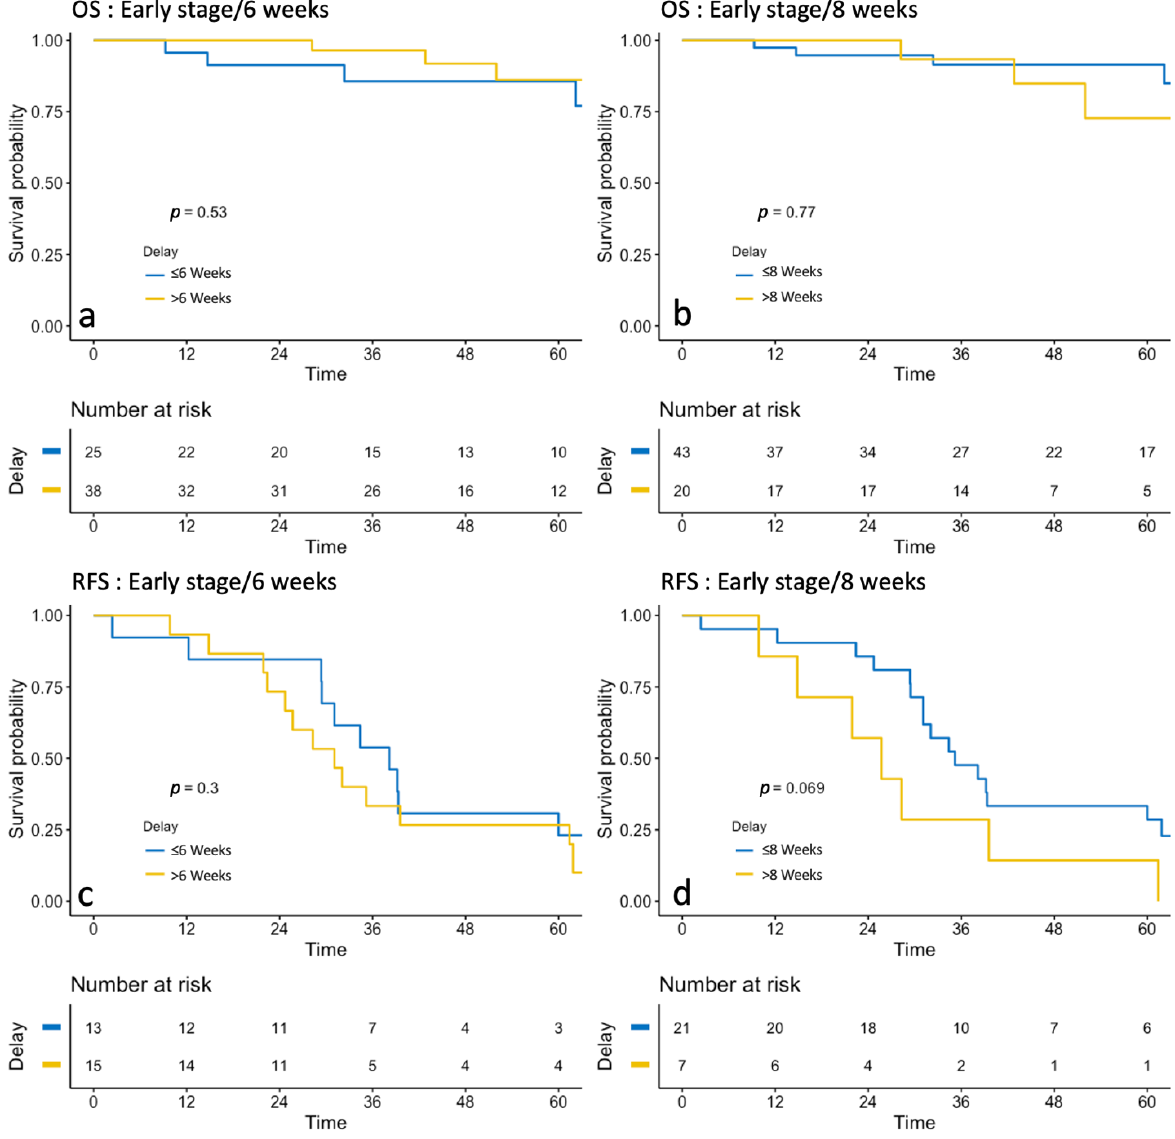
Figure 2. Survival analysis of Overall Survival (OS) (before and after 6 weeks: ( a ) before and after 6 weeks: ( b ) and Recurrence-free Survival (RFS) (before and after 6 weeks: ( c ), before and after 6 weeks: ( d ) in Early stages.